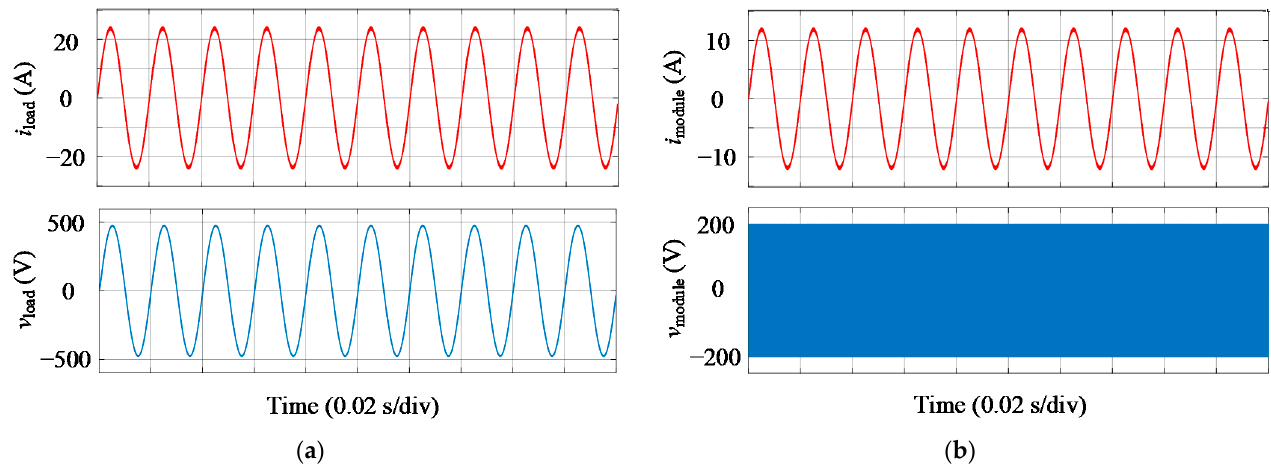
Figure 13. Simulation results of the lattice converter with pulse-width modulation: ( a ) The load current iload and load voltage vload; ( b ) The module current imodule and module voltage vmodule.